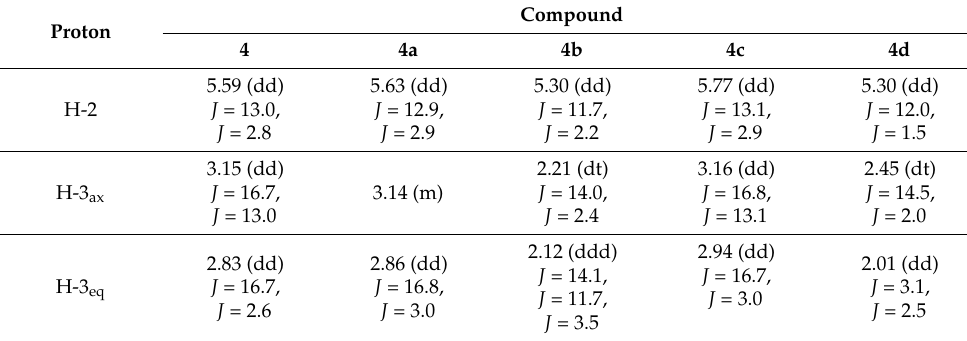
Table 1. 1 H-NMR chemical shifts δ (ppm) and coupling constants J (Hz) of 4 (cid:48) -methylflavanone ( 4 ) and products of its biotransformations, 4a – 4d , in acetone-d6, 600 MHz (Supplementary